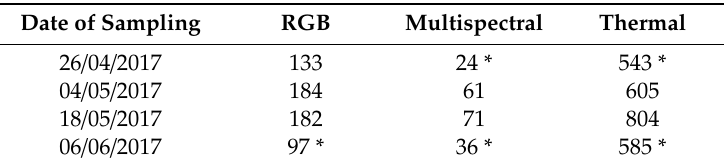
Table 2. Number of images comprising each orthomosaic. *, the values refer to the flights conducted over the late-planting